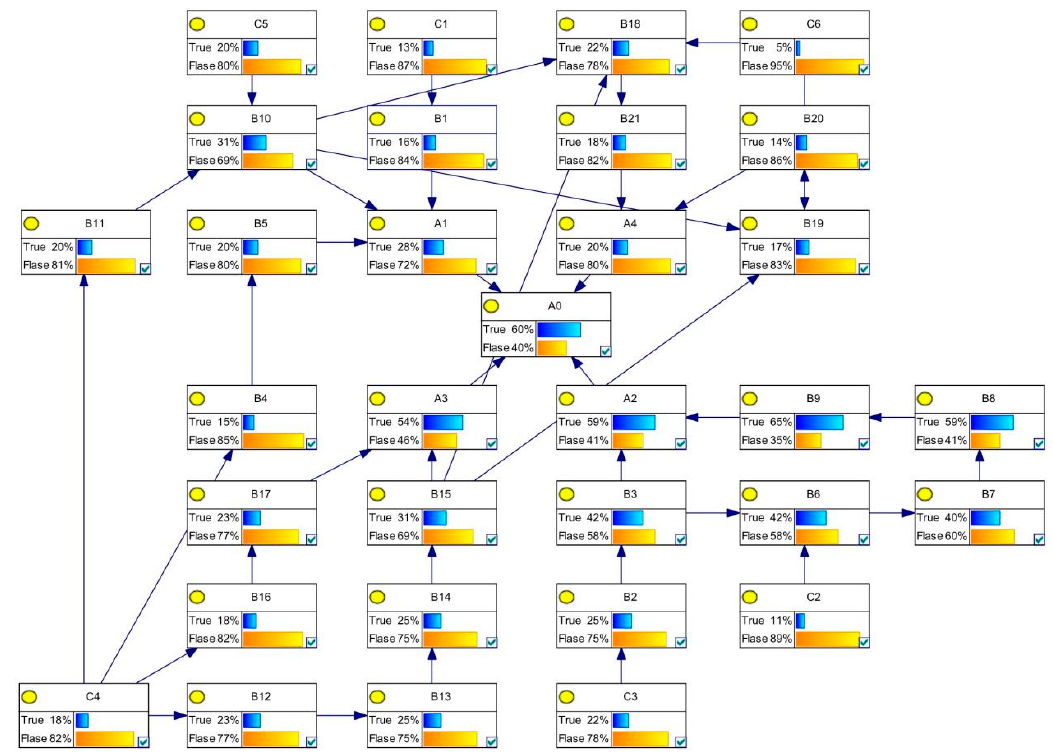
Figure 5. Analysis diagram of catenary construction risks Bayesian network forward inference.